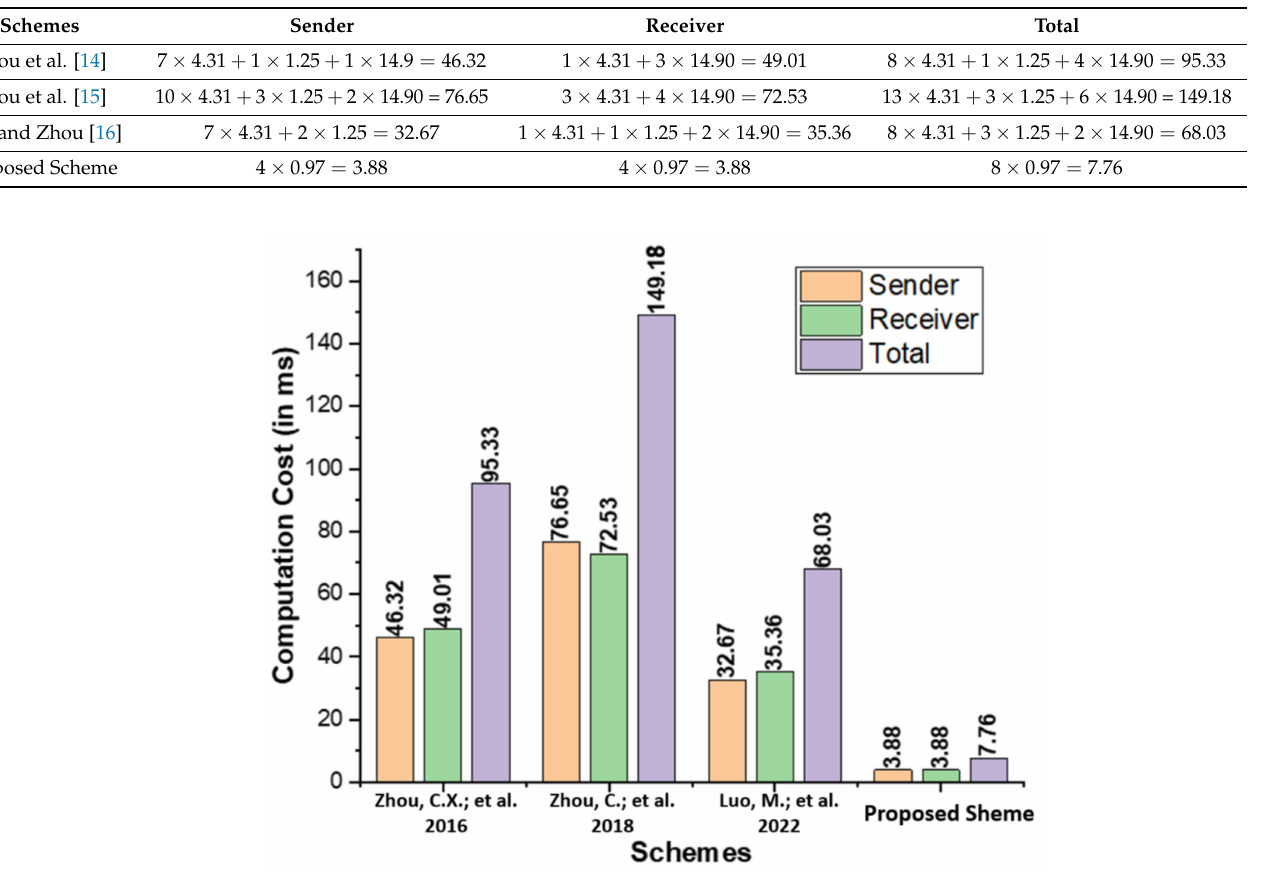
Figure 3. Comparison of computation cost (in ms)